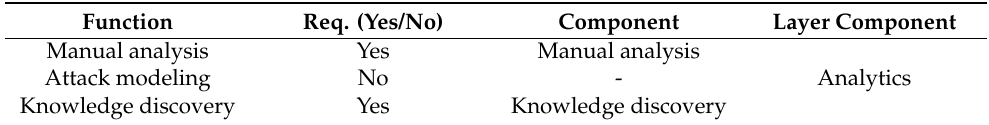
Table 5. Application of CTI Reference Model: Analytics Layer.